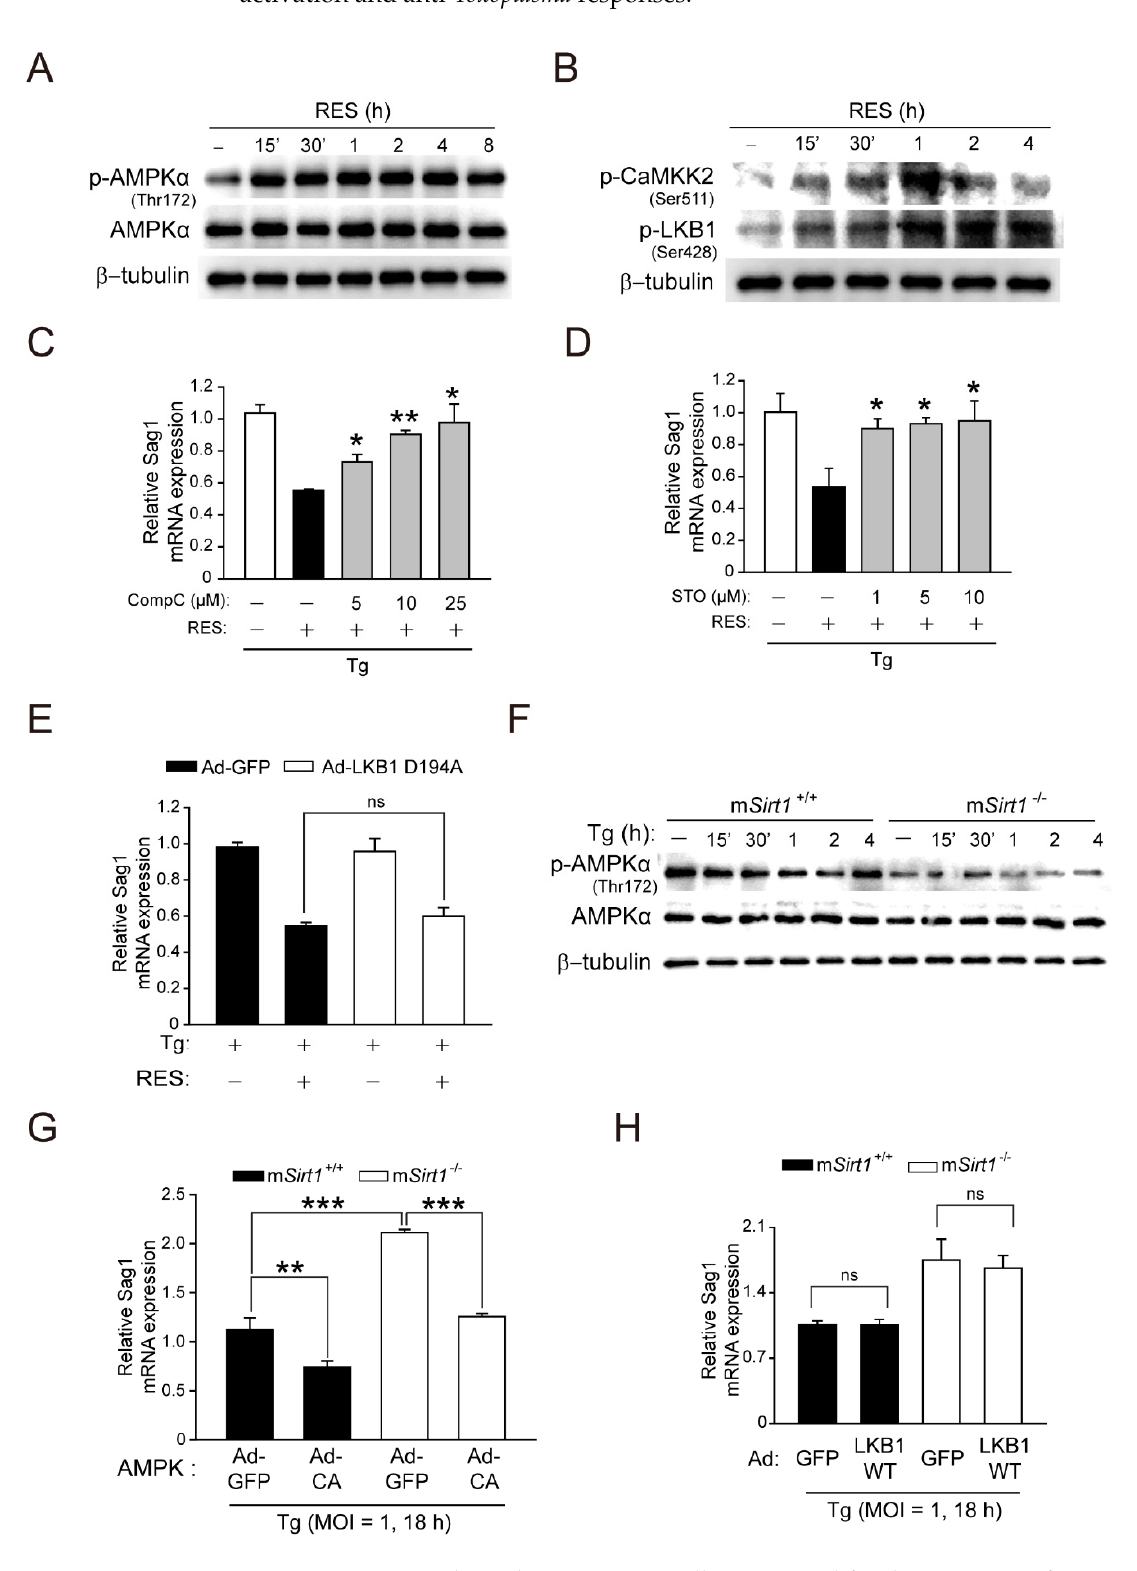
Figure 5. CaMKK2-dependent AMPK signalling is crucial for the activation of SIRT1-mediated antiparasitic responses against Toxoplasma infection in primary murine macrophages. ( A , B ) BMDMs were stimulated with RES (10 µM) for the various time periods, and then immunoblot analysis was assessed to evaluate the phosphorylation of AMPK α (for A ) or CaMKK2 and LKB1 (for B ). ( C , D ) BMDMs were pretreated with increasing concentrations of CompC (5, 10, or 25 µM, for C) or STO (1, 5, or 10 µM, for D ) for 45 min, then infected with T. gondii RH strain (MOI = 1) for